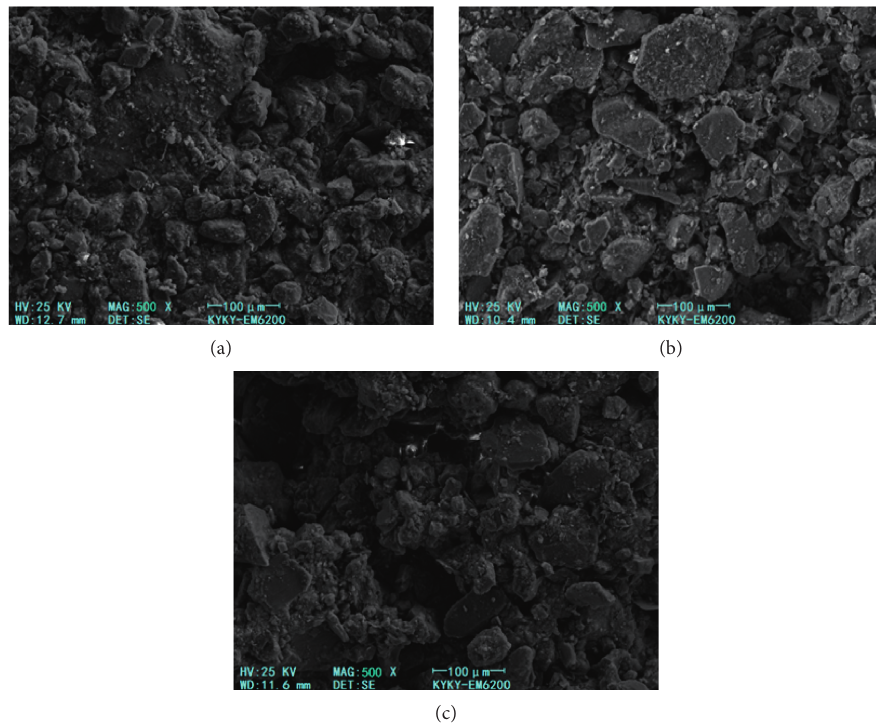
Figure 18: Microstructure of the reinforced soil after different number of dry-wet cycles. (a) 0 times. (b) 7 times. (c) 30